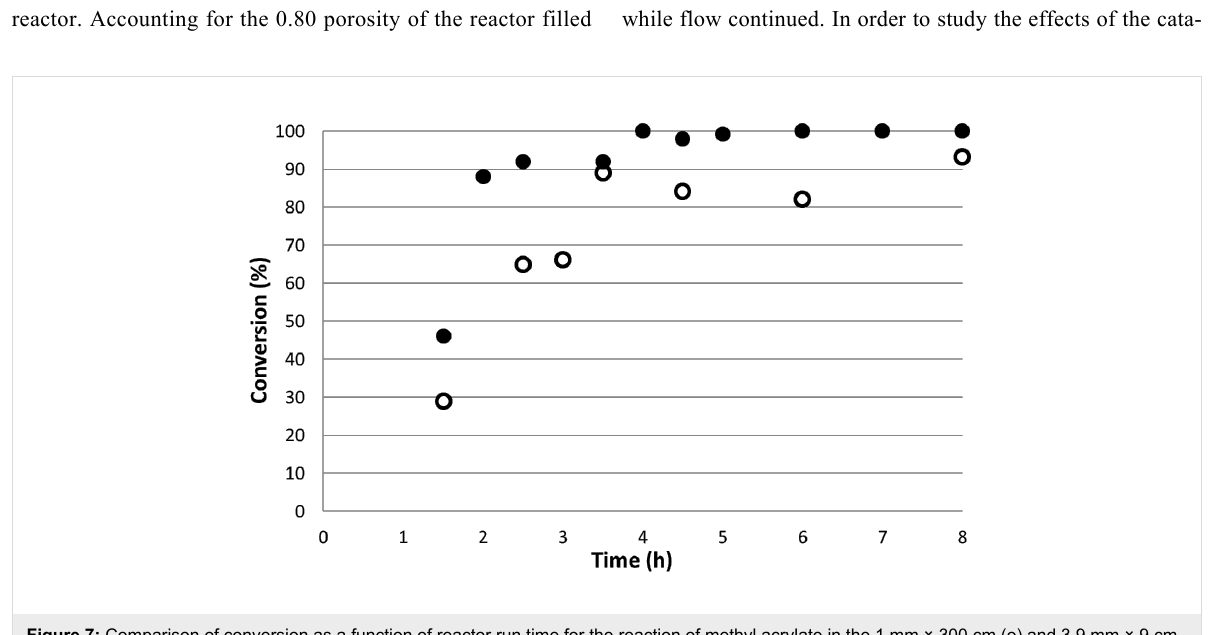
Figure 7: Comparison of conversion as a function of reactor run time for the reaction of methyl acrylate in the 1 mm × 300 cm ( ο ) and 3.9 mm × 9 cm ( ● ) plug flow reactors over the Pd-SiO 2 catalyst.